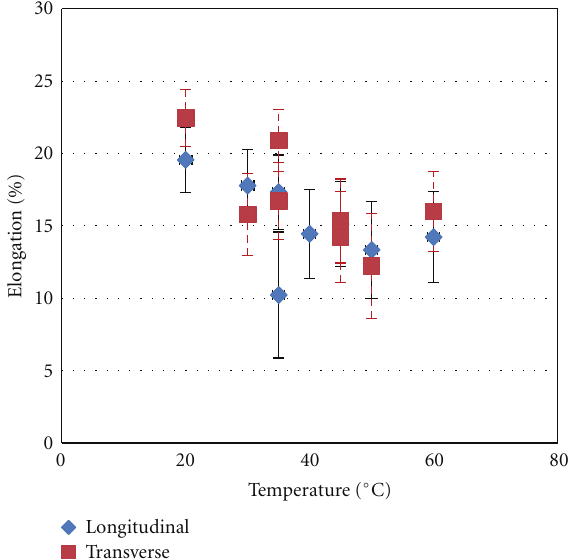
Figure 3: Elongation as a function of temperature for specimens machined longitudinal and transverse to the rolling direction, at 800 kPa with a gas mixture of 25% CO and 75% CO 2 .